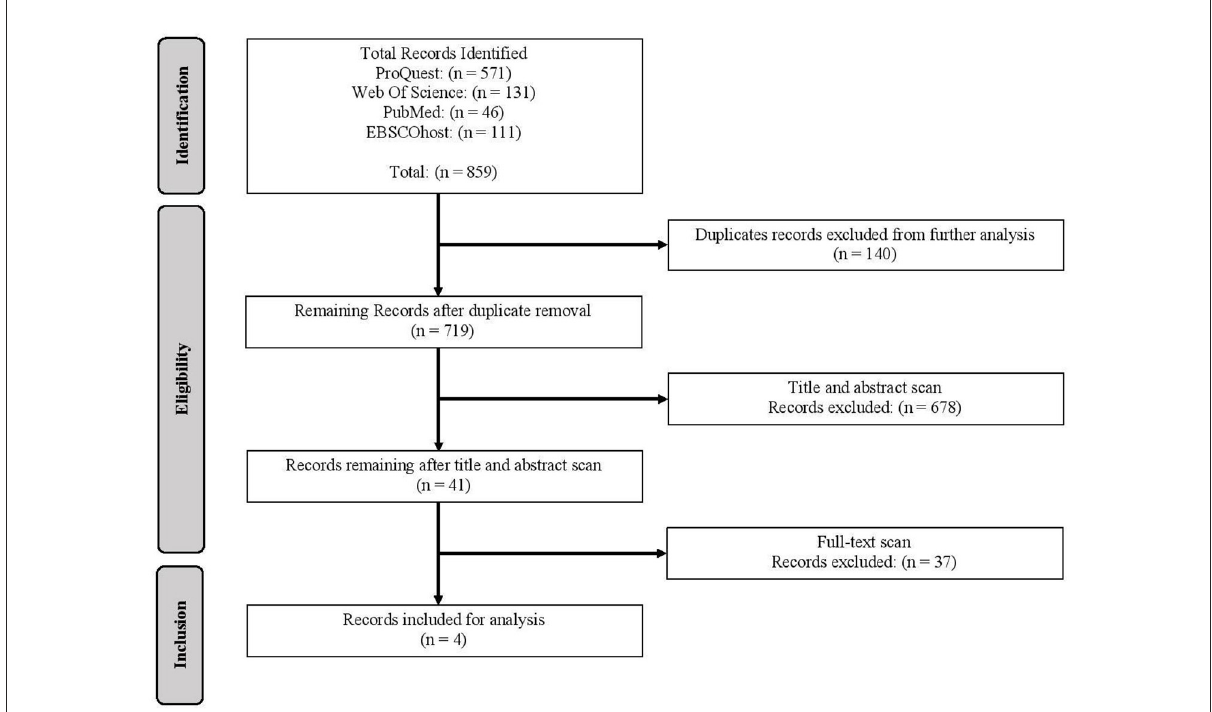
FIGURE2 Systematic literature eligibility results for how Indigenous and Black communities uniquely interact with Canadian systems and